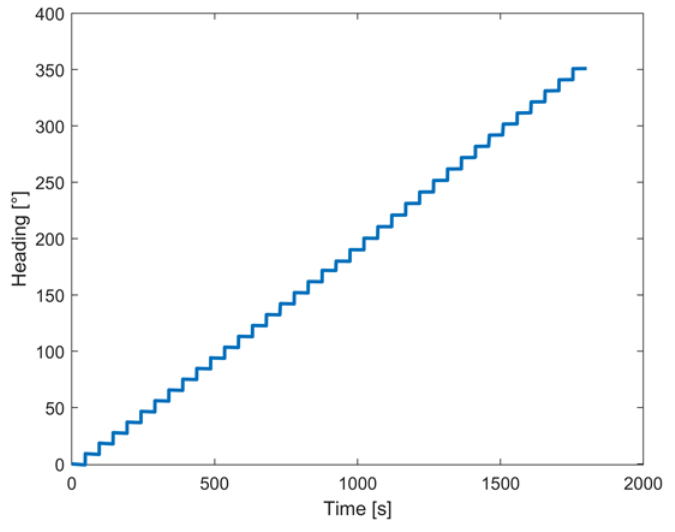
Figure 7. Measured angles from 0° to 360° with a step of 10°.